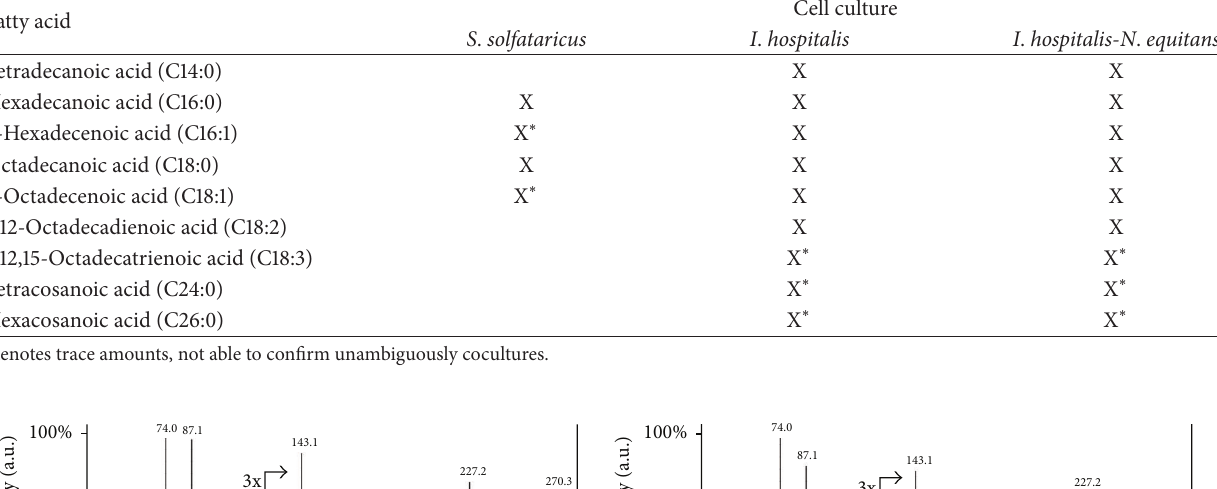
Table 1: Fatty acids identified in archaeal cell extracts of S. solfataricus , I. hospitalis , and I. hospitalis-N. equitans . Fatty acid